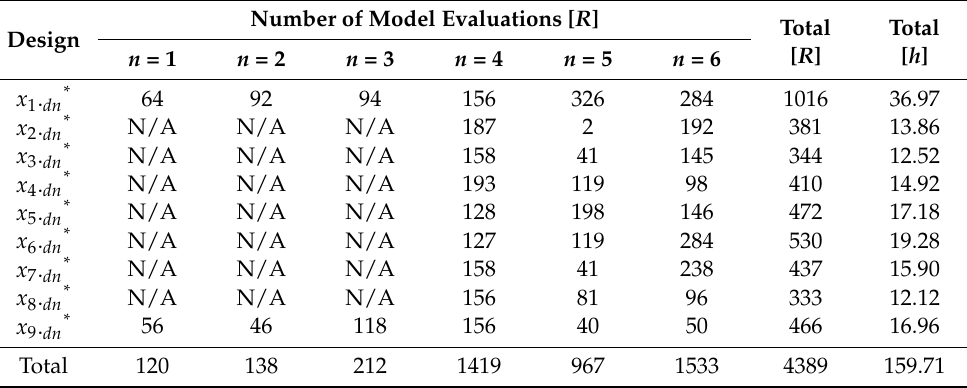
Table 1. Cost breakdown of the multi-objective optimization of the spline-parameterized antenna. Number of Model Evaluations [ R ] Total Design